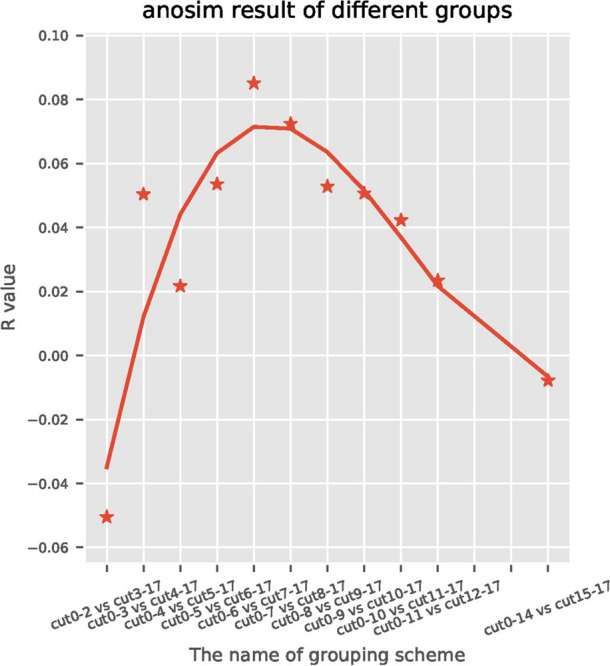
Anosim analysis is a statistical method used to analyze the significant differences between high-dimensional data of each group and to assess the integrity and significance of the differences between two groups. A positive R value indicates a significant difference between each group and the difference depends on the absolute value of R. The horizontal axis represents the month of death, the vertical axis represents the R value, and each spot represents the difference of R value between the two groups corresponding to different months of death. The most significant difference (R = 0.10, P = 0.02) was observed in the cut seven sub-group, which indicates that the 7th month was the inflection point of the gut microbiota changes.